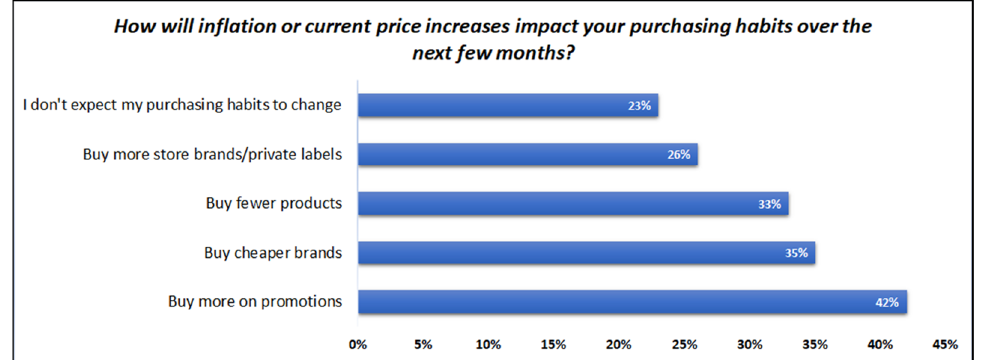
Figure 1. Impact of purchasing decision of consumers due to inflation or higher prices. A higher percentage (80%) of the consumers would choose at least one of the above. Source: Ipsos Coronavirus Consumer Tracker, fielded 4–5 January 2022, among 1600 U.S. adults [2].